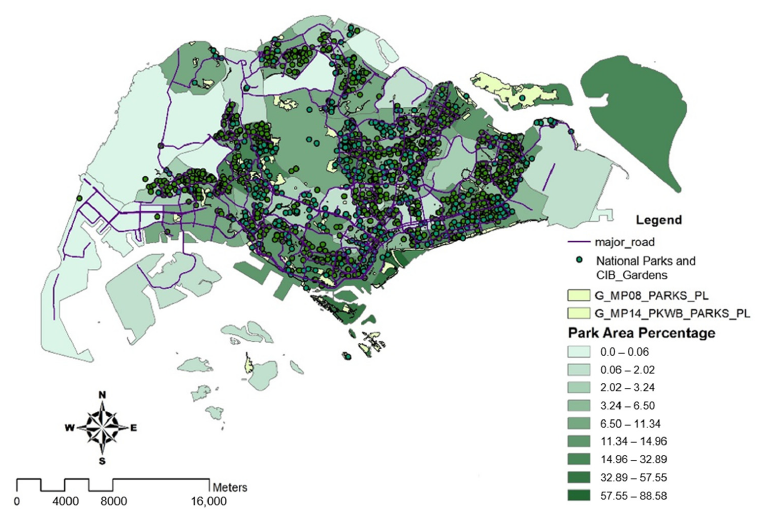
Figure 5. Spatial distribution of park area percentage. The map displays the total percentage of parks and CIB gardens across the region using the data-specific classification technique ‘Natural Breaks’, with dark colors representing a high percentage of park area and light colors representing either none or a small percentage of park